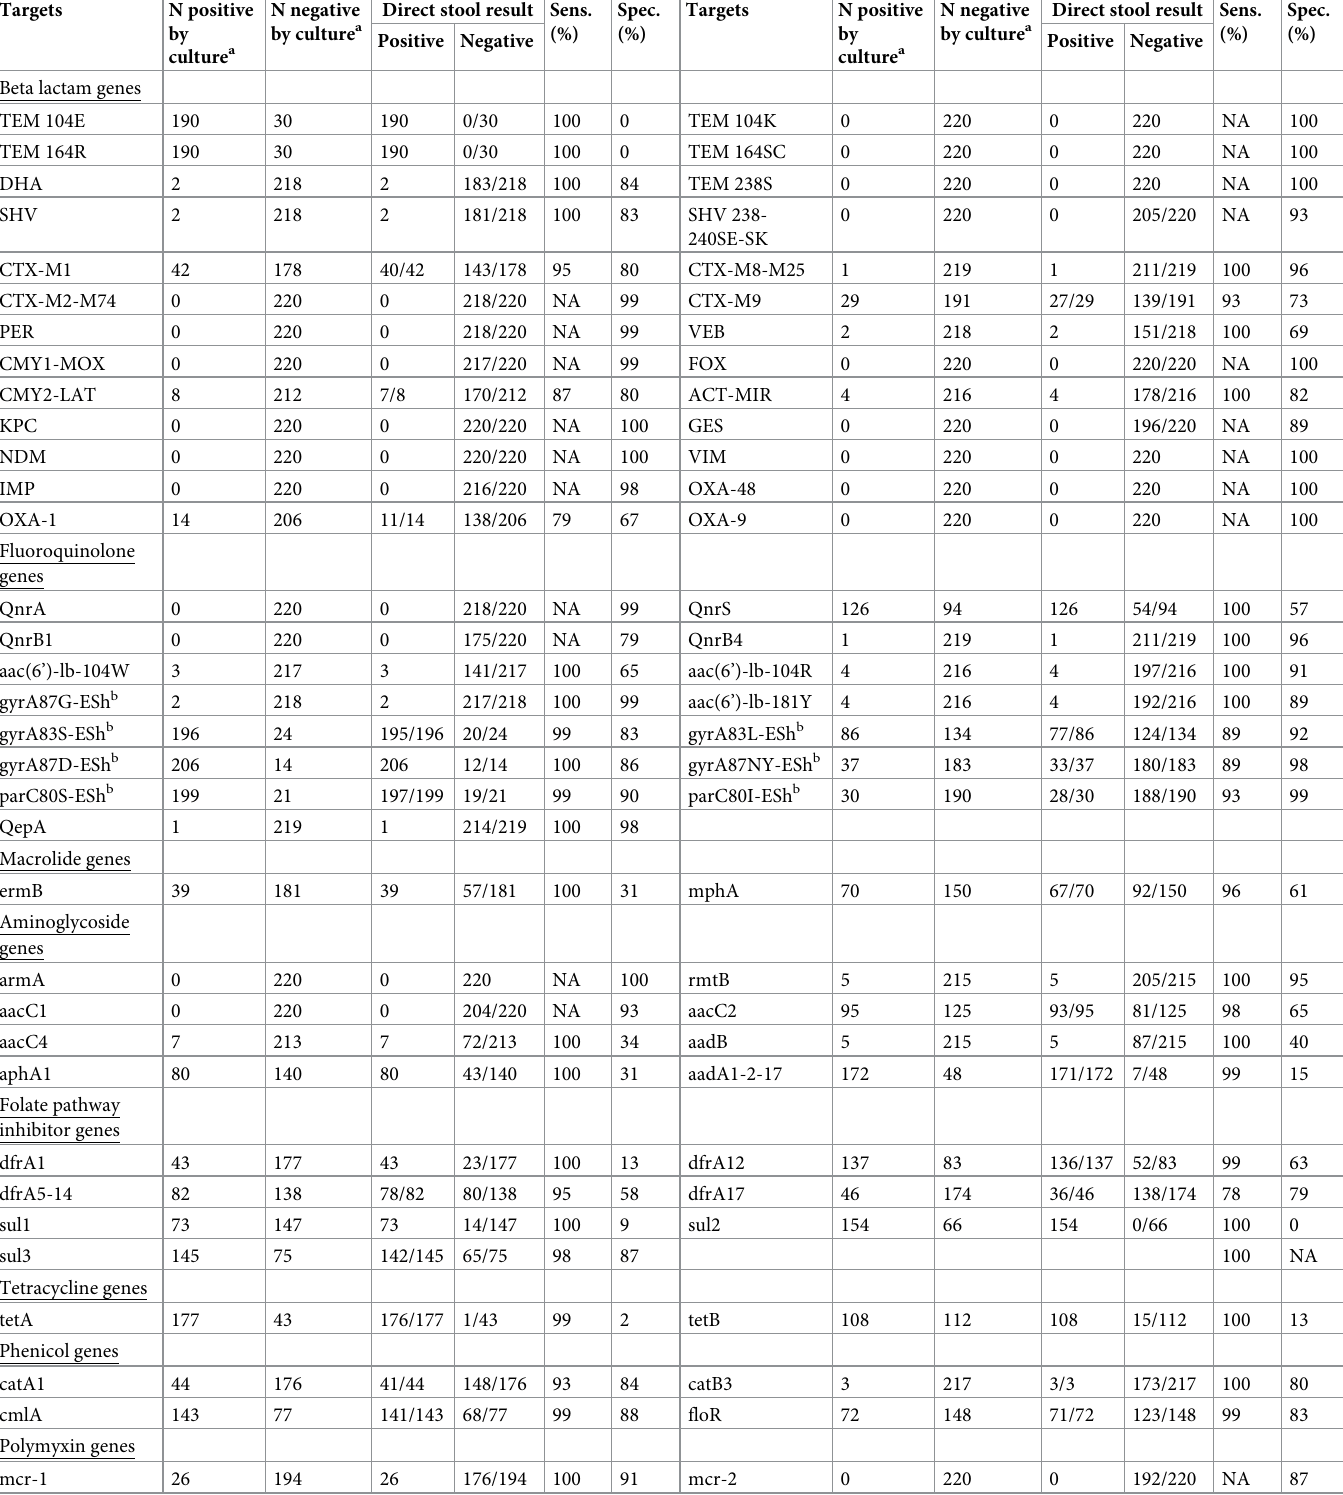
Table 3. Comparison of AMR-PCR assay detection in direct stool and paired E . coli isolates (N = 220).